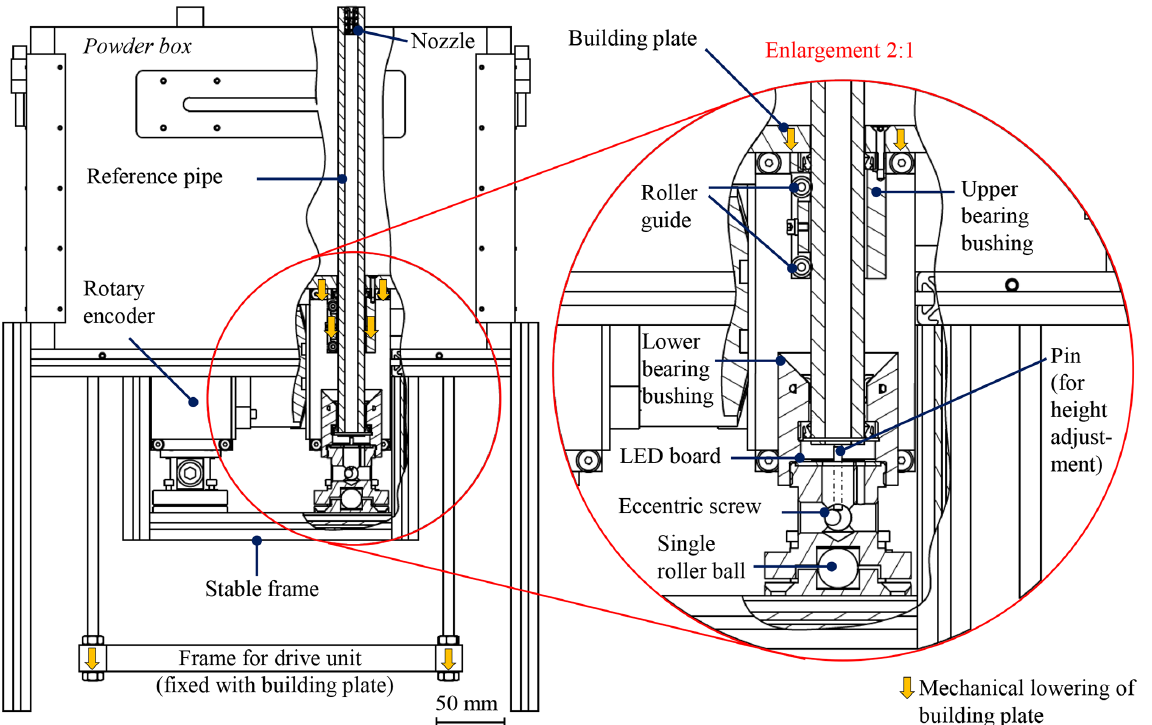
Figure 4. Integration of reference system in the building plate of the powder